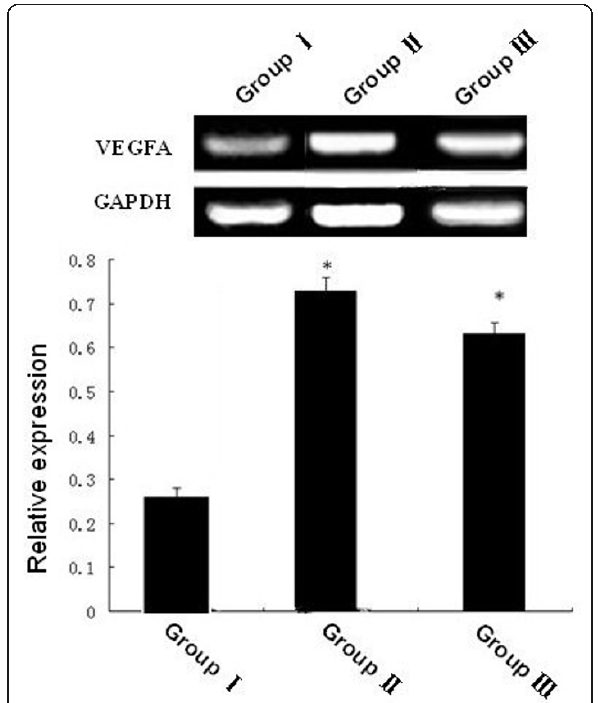
Figure 5 VEGFA mRNA expression on day 3 . (* P < 0.05 as compared with group Ⅰ